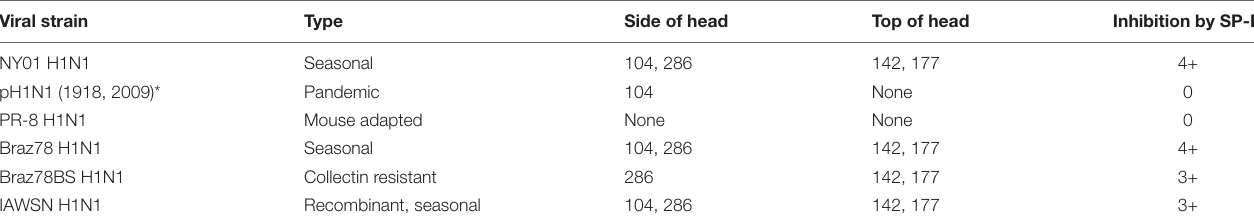
TABLE 1 | Major predicted or known glycosylation sites on H1N1 HA molecules of various influenza A virus (IAV) strains and approximate inhibition by wild-type full-length SP-D for each strain. Viral strain Type Side of